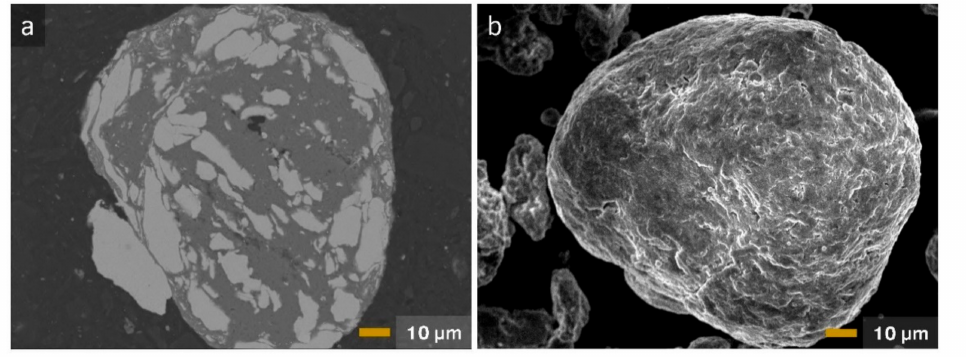
( a ) Cross-section and ( b ) exterior appearance of a nearly spherical particulate of Ti / Al mechanocomposite.